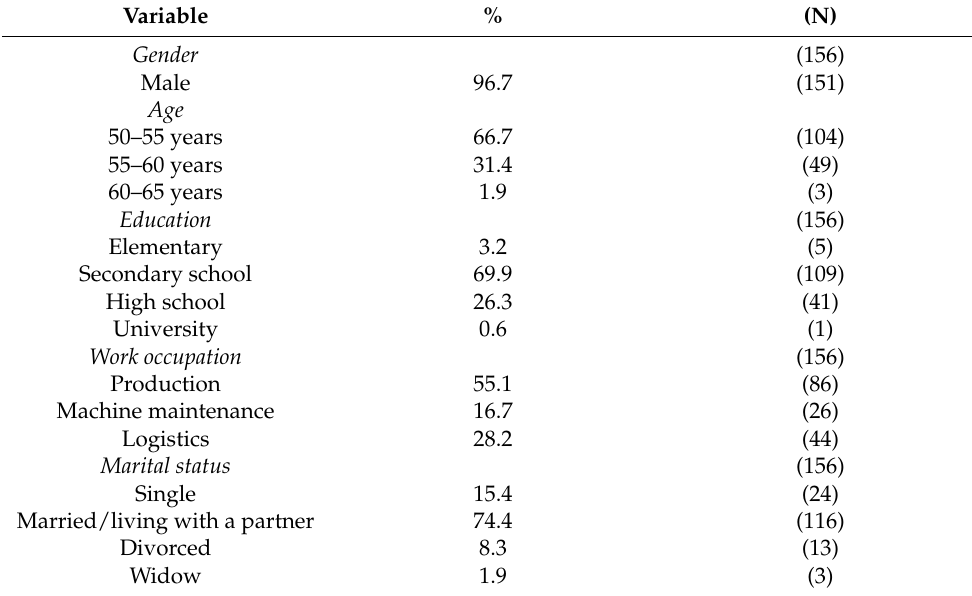
Table 1. Descriptive statistics of the total sample (N =